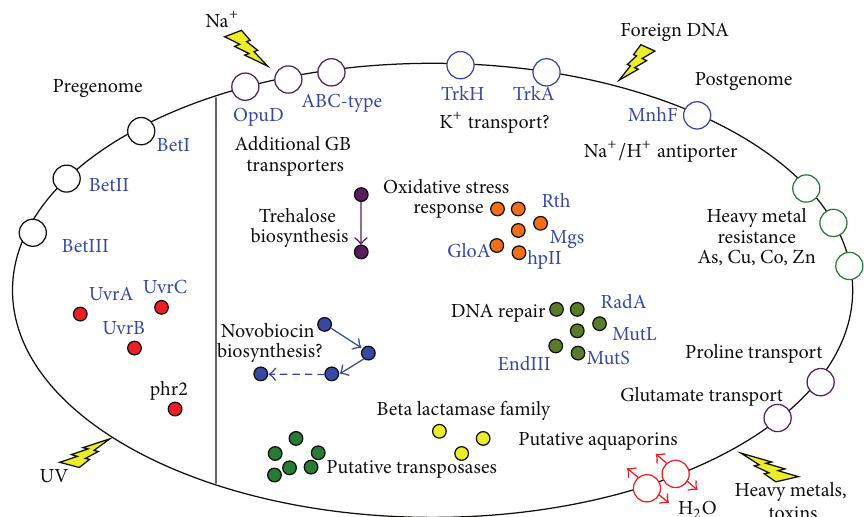
Figure 3: Schematic representation of some of the putative adaptive traits present in H. hamelinensis . The traits identified pregenome is indicated on the left, and those elucidated postgenome in the present study are indicated on the